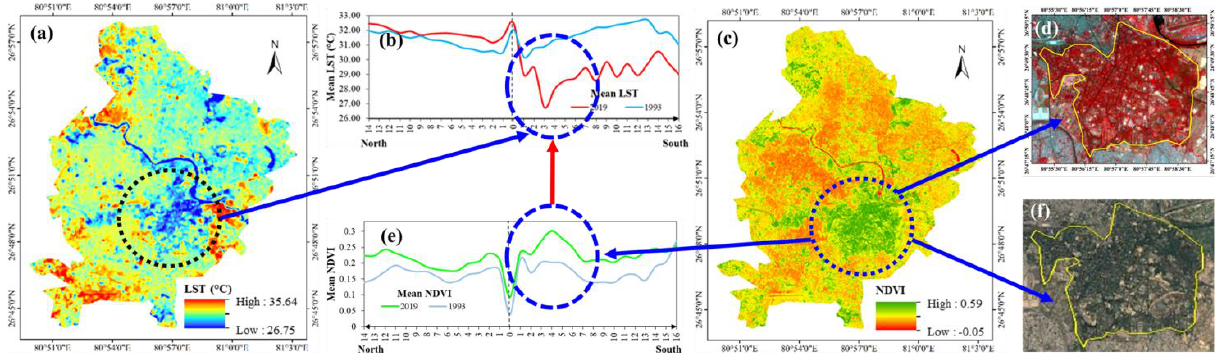
Figure 5. Validation of vegetation growth in south-east direction and its effect on LST in same direction using Landsat image and Google Earth Image: (a) LST in time-point of 01/06/2019; (b) LST distributional profile on south-east direction in time-point of 01/06/2019; (c) NDVI in time-point of 01/06/2019; (d) NDVI distributional profile on south-east direction in time-point of 01/06/2019; (e) Selected circle portion on Landsat OLI/TIRS image in time-point of 01/062019; (f) Selected circle portion on Google Earth image in time-point of